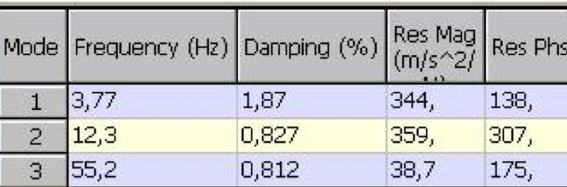
Table 2. Modal results: Mode Indicator - Modal Peaks